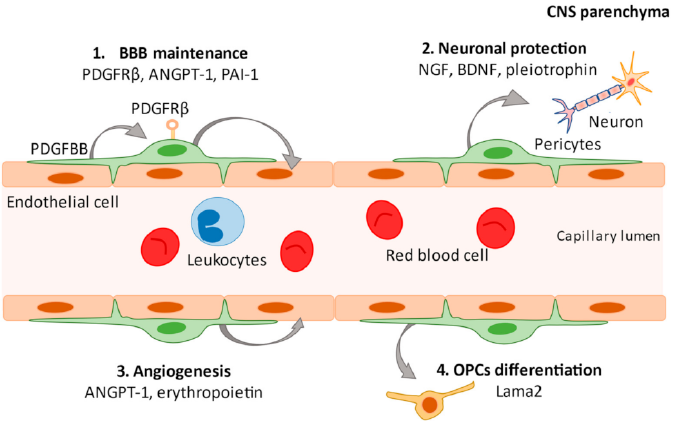
Figure 1. Regulatory functions of pericytes. In the central nervous system (CNS), platelet-derived growth factor-beta subunit (PDGF-BB) is released by endothelial cells and binds to PDGFR β at the cell surface of pericytes to promote pericyte vascularization within the blood–brain barrier (BBB). Secretion of angiopoietin-1 (ANGPT-1) and plasminogen activator inhibitor type 1 (PAI-1) from pericytes promotes the development of vascular endothelial cells and contributes to the maintenance of the BBB (1). Pericytes maintain neuronal health by secreting factors such as nerve growth factor (NGF), brain-derived nerve growth factor (BDNF), and pleiotrophin (2). Pericytes are involved in angiogenesis by secreting ANGPT-1 and erythropoietin (3) and produce a factor (Lama2) that facilitates the differentiation of oligodendrocyte progenitor cells (OPCs) into mature oligodendrocytes (4).